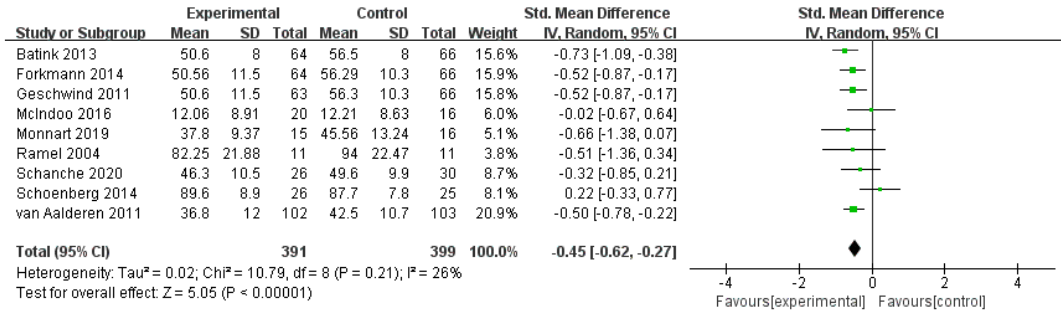
Figure 8. Meta − analyses of the effects of MBIs on anxiety [31,32,35,36,40,43,44,47,48].